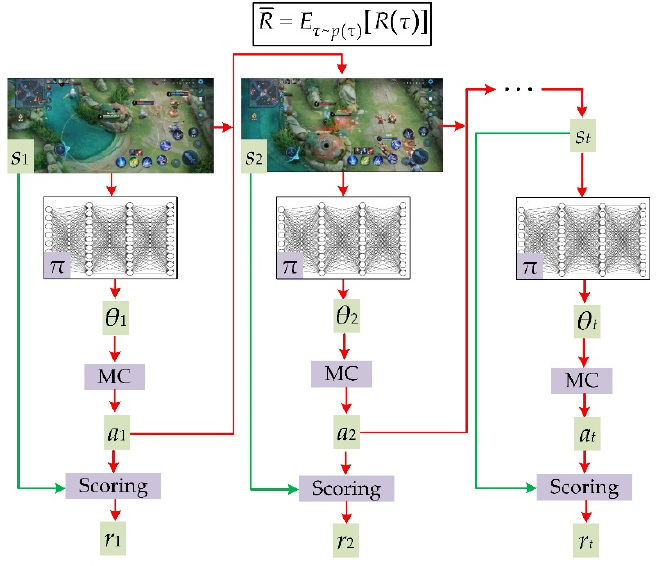
Figure 1. Schematic plot of applying DRL to play a video game. MC is short for Monte Carlo sampling, r t is the reward of the state–action pair ( a t | s t ), the box at the top shows the objective function (Equation (3)).